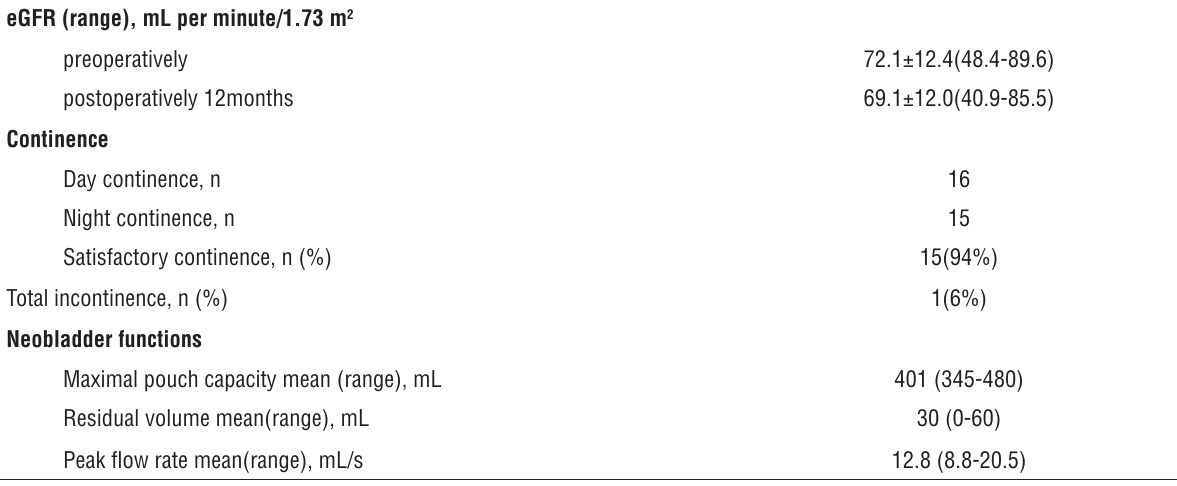
Table 2 - eGFR, Urinary continence and neobladder function of 16 patients at postoperative 12 months. eGFR (range), mL per minute/1.73 m